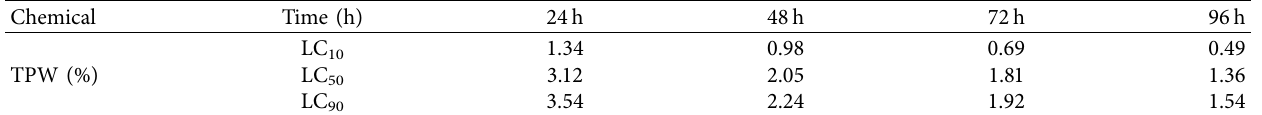
Figure 6: Response optimization plot of individual: (a) TC and (b) TOC removal efficiency in RWP using EF. Table 4: Lethal dose LC 50 of the TPW samples on D. magna .